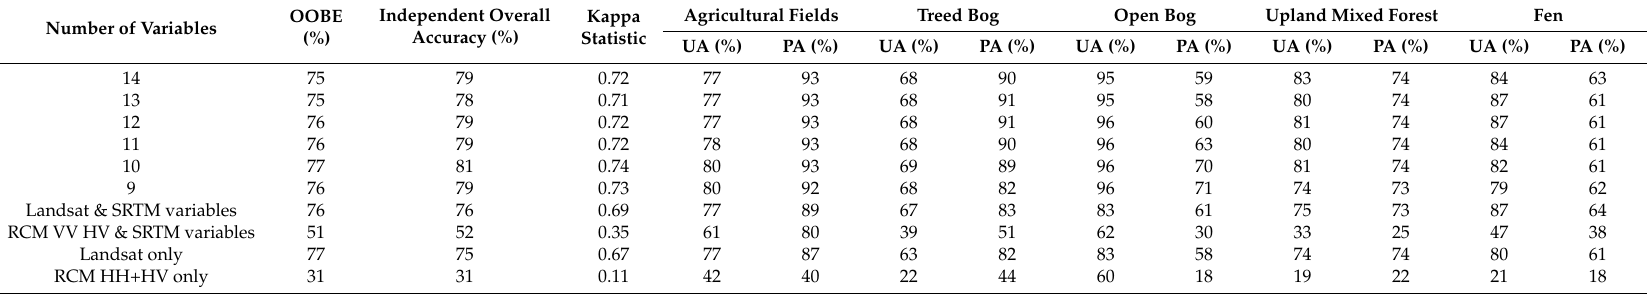
Table A14. Statistical results from the RCM Dual Pol VV+VH NESZ − 25 dB (13 July 2014), Landsat-8 (27 June 2014), SRTM variables summer model. The first iteration was run with all 14 variables, and variables ranked to be unimportant were then removed until 9 variables remained. The final variables in the model with the highest independent overall accuracy (10 variables) in order of decreasing importance were the seven Landsat-8 bands, HV Intensity, SRTM DEM, and SRTM